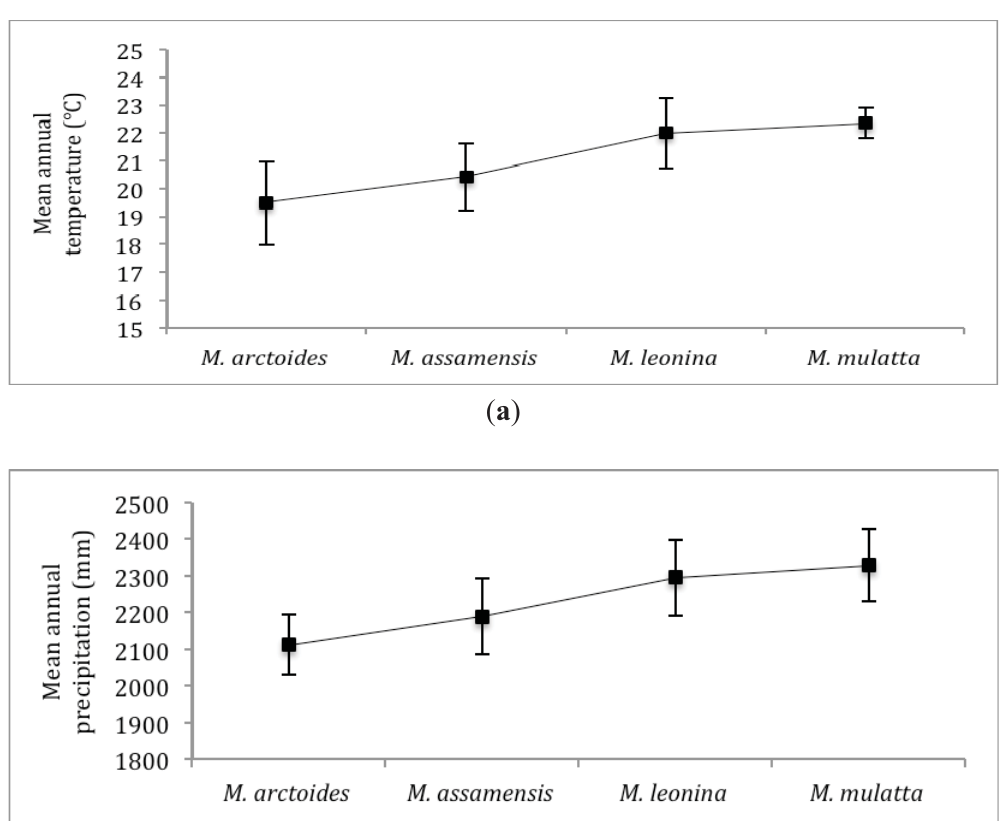
Figure 3. Mean (and standard deviation) annual temperature ( a ), annual precipitation ( b ), elevation ( c ) and slope ( d ) in respective predicted distribution of each macaque